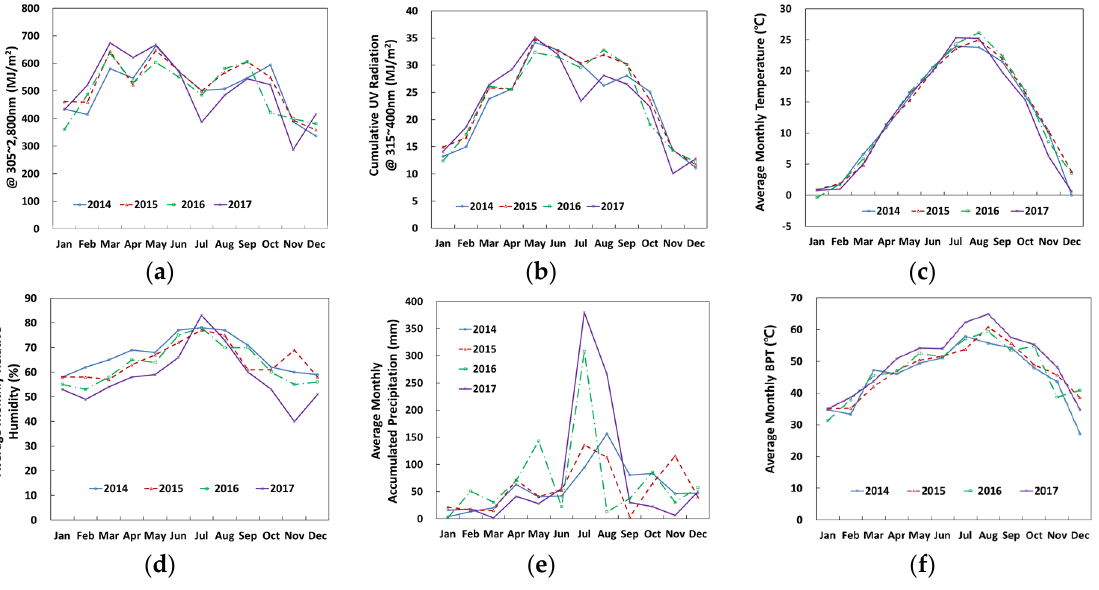
Figure 2. Four-year outdoor weathering information at Seosan, Korea: ( a ) cumulative solar radiation; ( b ) cumulative UV radiation; ( c ) average monthly temperature; ( d ) average monthly relative humidity; ( e ) average monthly cumulative precipitation; and ( f ) average monthly BPT.